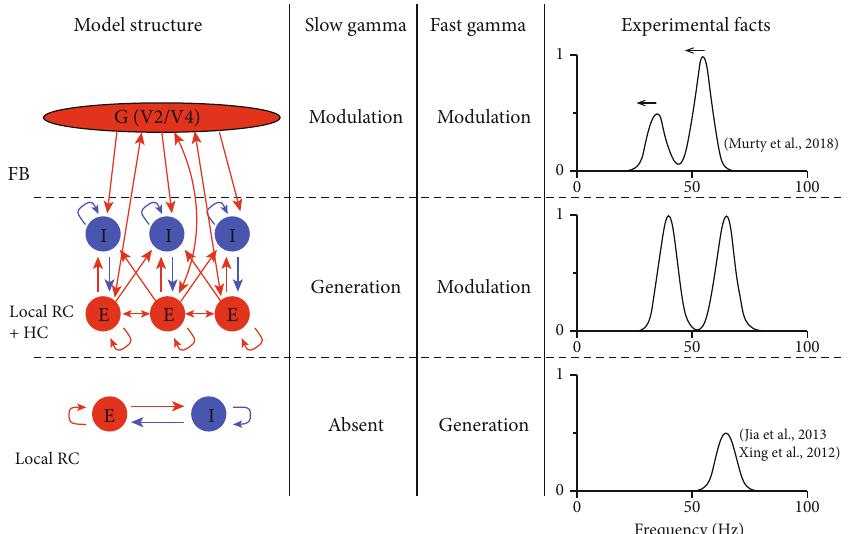
Figure 9: The summary for general roles of RC, HC, and FB in gamma oscillations in V1. This fi gure summarizes the roles of RC, HC, and FB for the generation and modulation of slow and fast gamma oscillations. Three rows in the fi gure show the function of local RC, HC, and FB to generate or modulate gamma oscillations. The demo of the power spectrum is shown in the right